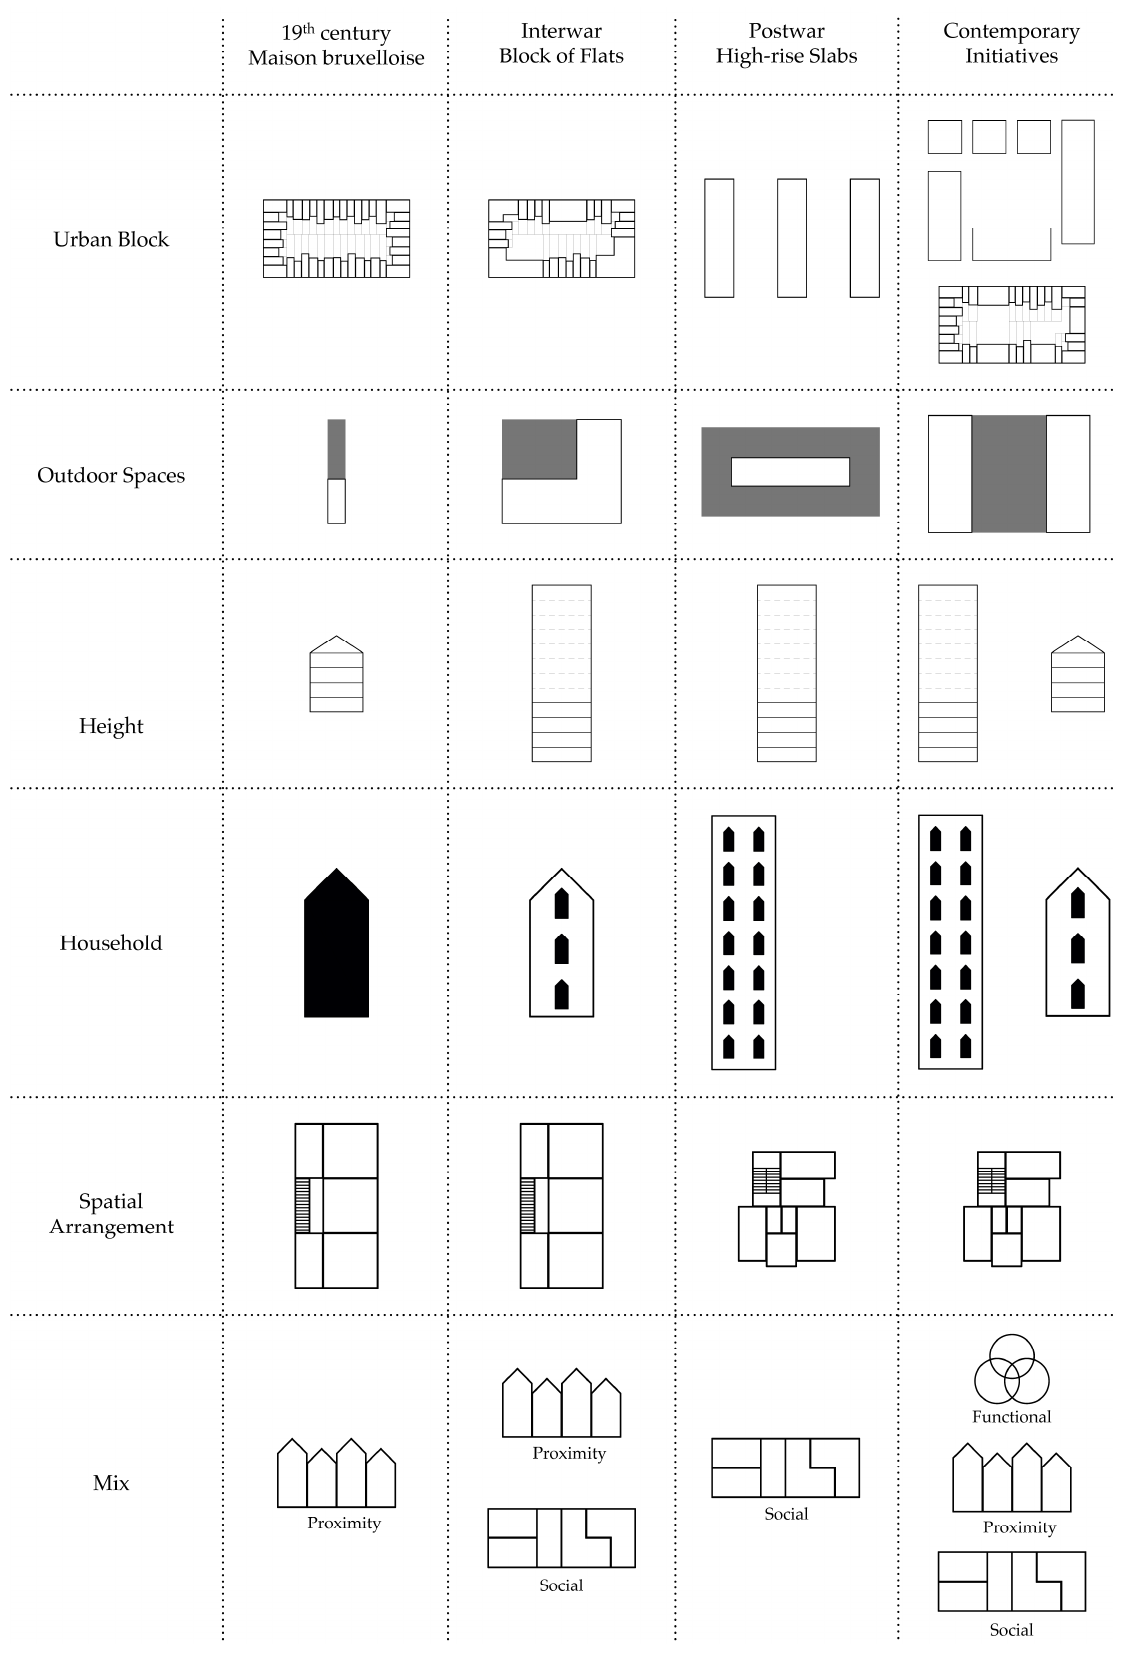
Figure 15. Recapitulatory comparison of urban, spatial and social features between residential schemes from Brussels crisis